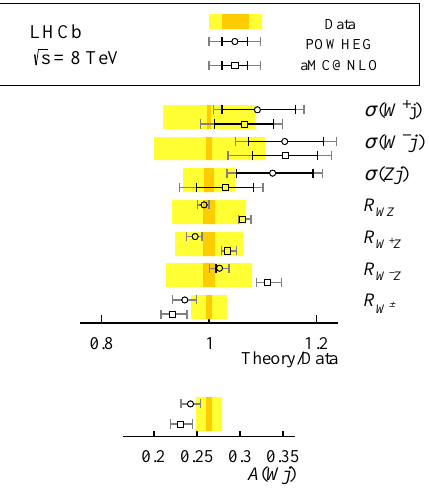
(cid:112) s = 8TeV [ 15 ] . The